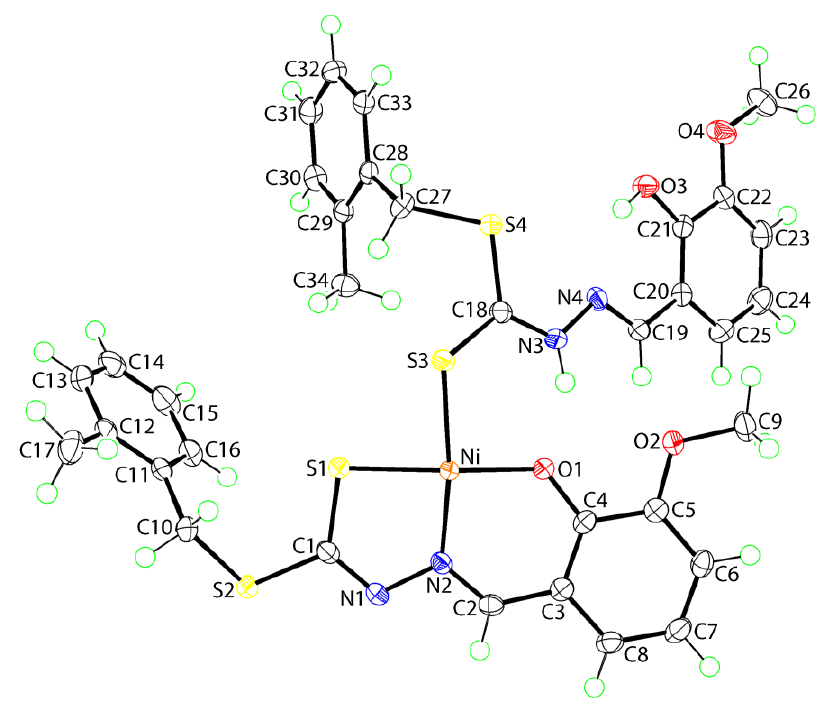
Figure 1. The molecular structure of 1 showing atom labeling and displacement ellipsoids at the 70% probability level. Selected geometric parameters: Ni-S1 = 2.1512(4) Å , Ni-S3 = 2.2290(4) Å , Ni-O1 = 1.8615(11) Å , and Ni-N2 = 1.8728(12) Å ; S1-Ni-S3 = 84.523(16)°, S1-Ni-O1 = 176.63(4)°, S1-Ni-N2 = 87.40(4)°, S3-Ni-O1 = 93.99(3)°, S3-Ni-N2 = 171.02(4)°, and O1-Ni-N2 = 94.28(5)°.